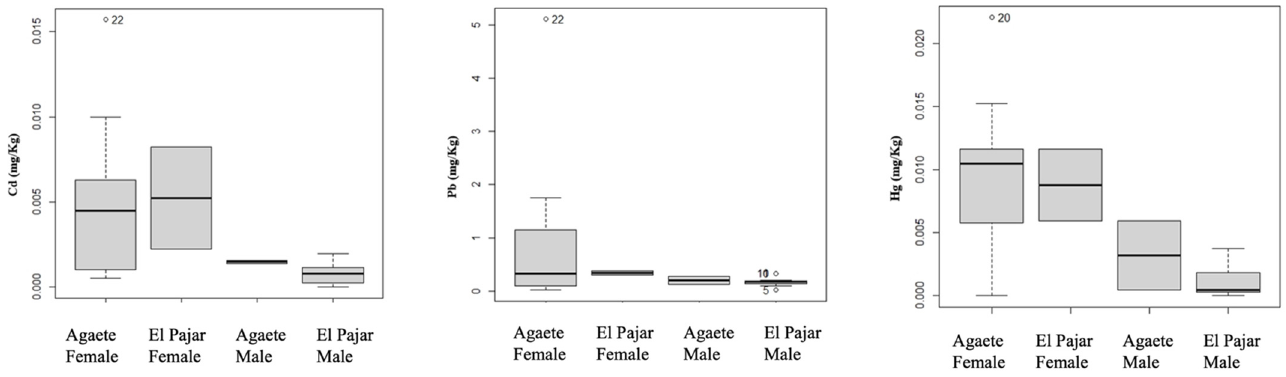
Figure 5. Box plot for Cd, Pb, and Hg (mg/kg) in exoskeleton with the location and sex factors.